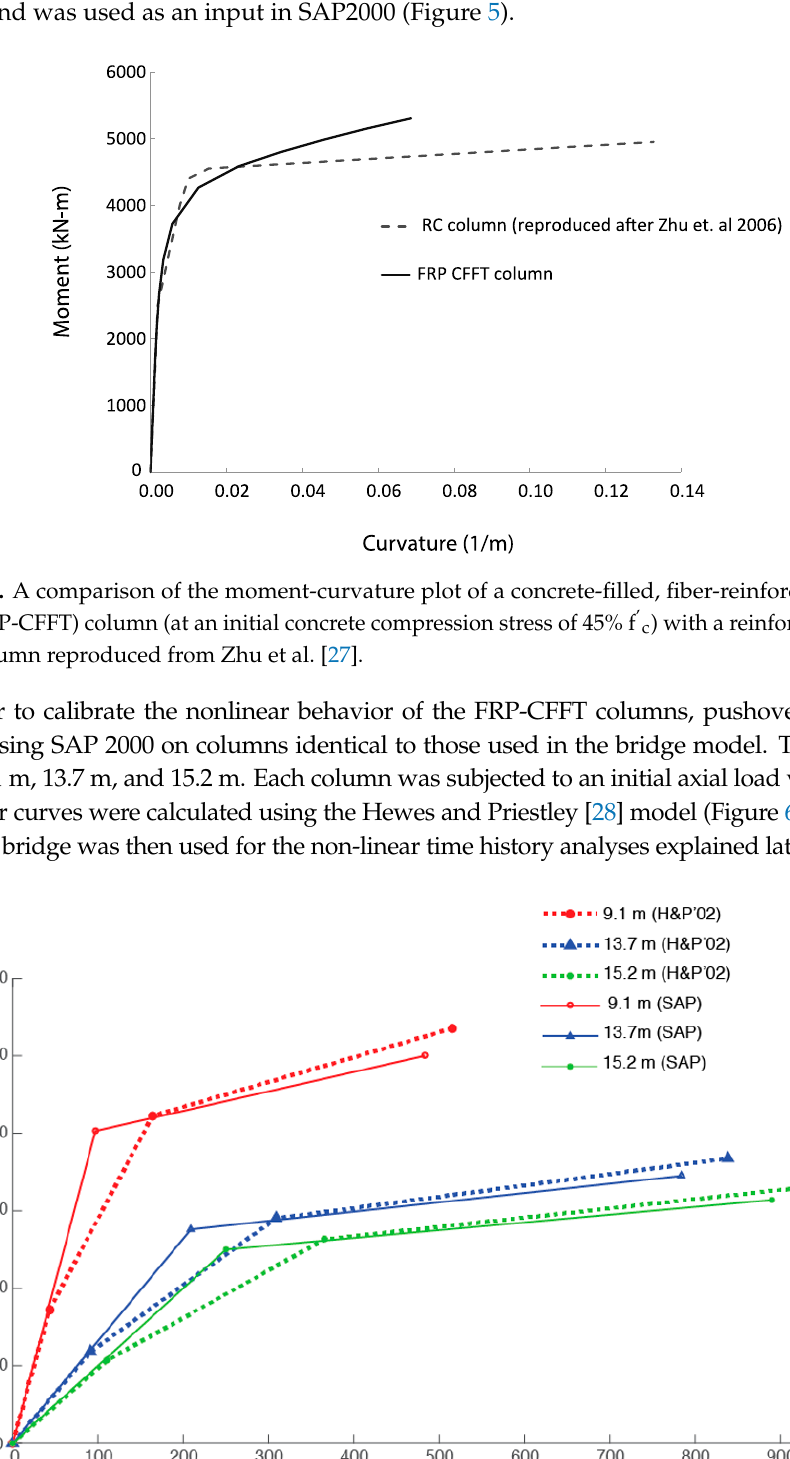
Figure 4. SAP2000 model of the bridge.